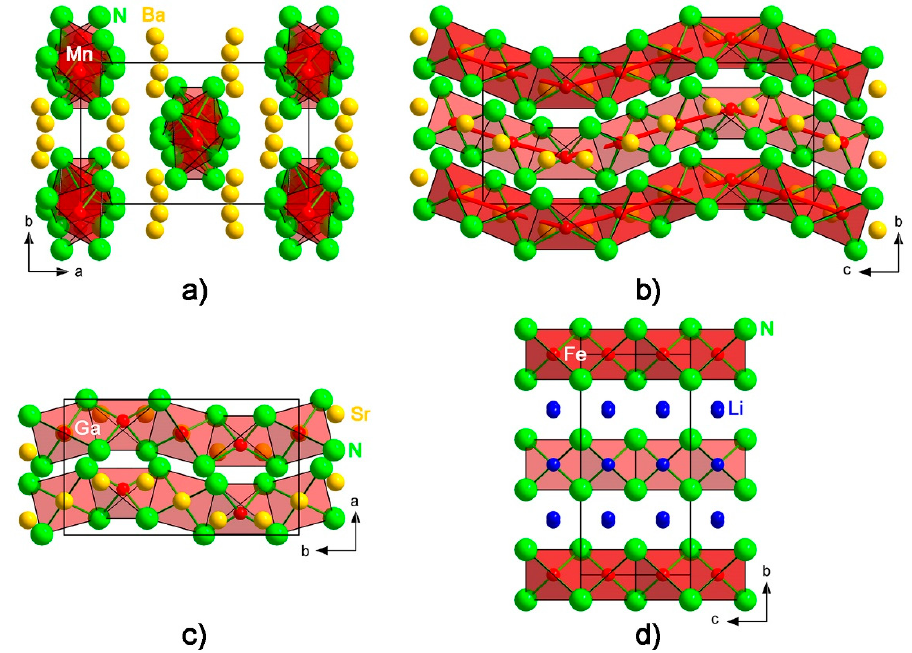
Figure 2. Crystal structure of Ba 4 [Mn 3 N 6 ] viewed along ( a ) [001] and ( b ) [100], for comparison, chains of edge-sharing tetrahedra in ( c ) Sr 3 [Ga 2 N 4 ] [26] and ( d ) Li 3 [FeN 2 ] [30] are drawn on the same scale.